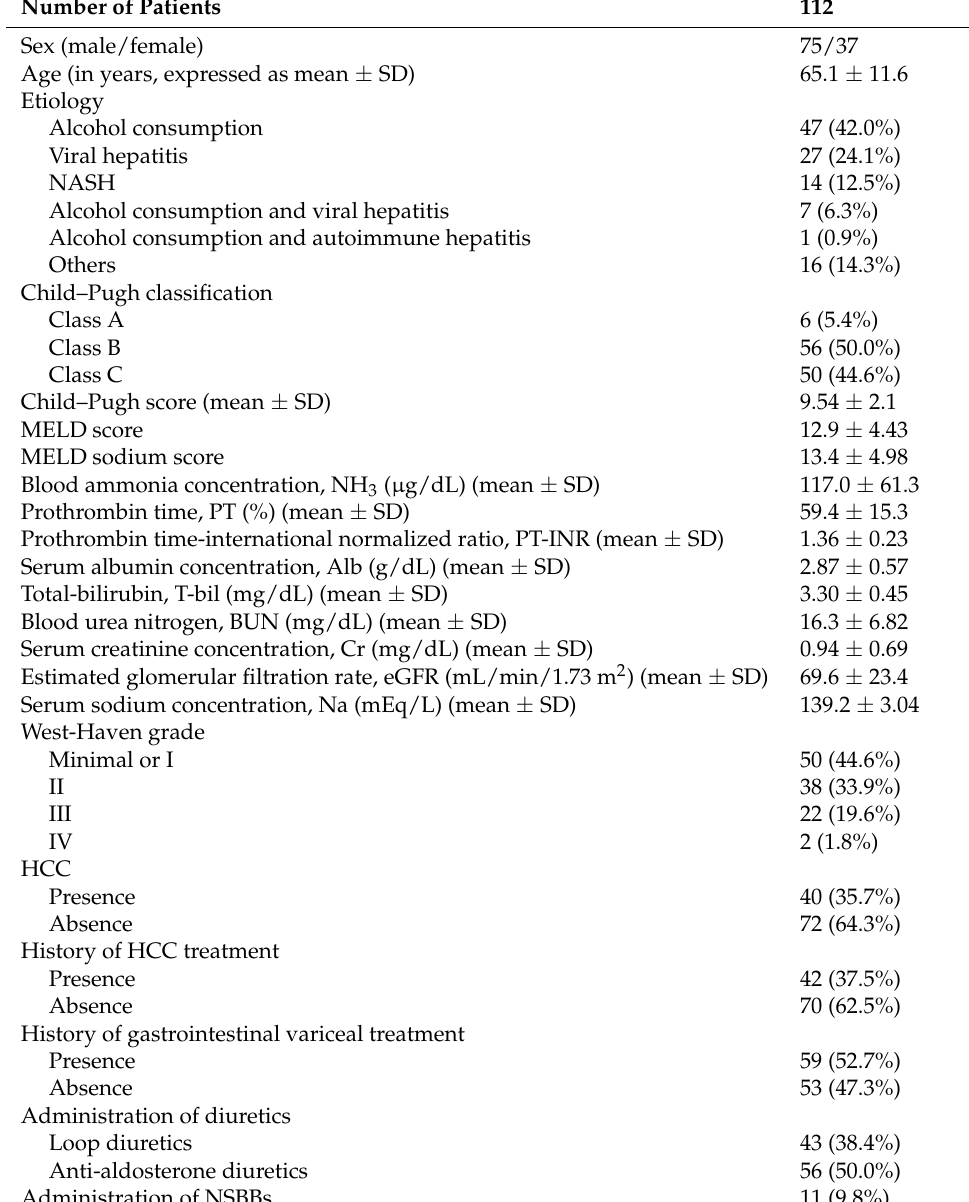
Table 1. Clinical characteristics of the study population.